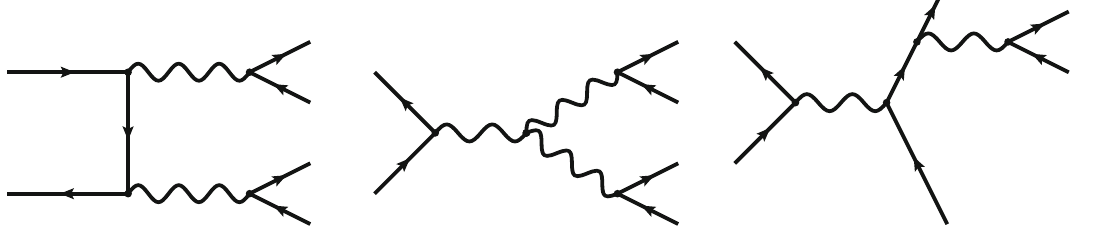
Fig. 1 Representative Feynman diagrams for the possible classes of resonance histories contributing at LO